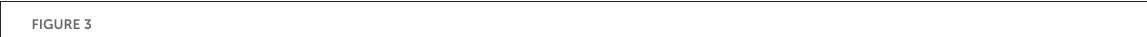
FIGURE3 indicated groups ( p < 0.05). With respect to VEGF-A release, it is of note that the data shown were normalized by subtracting the results obtained with FBS- or ePL-supplemented medium alone, thus they are indicative for VEGF-A released by the cells and from the ePL matrix. Endothelial cells from n = 1 donor were co-cultured with MSC from n = 5 donors.